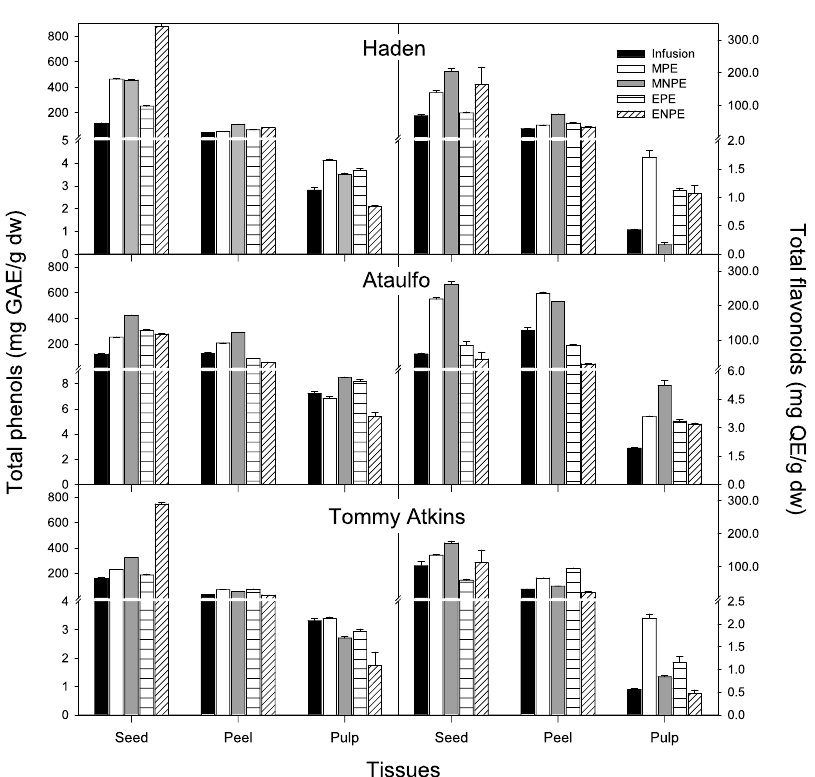
Fig. 1: Total phenolics and flavonoids from fresh-cut mango byproducts extracts. *Average of three determinations ± standard error, PME: Polar methanolic extract; NPME: Non polar methanolic extract; PEE: Polar ethanolic extract; NPEE: Non polar ethanolic extract.